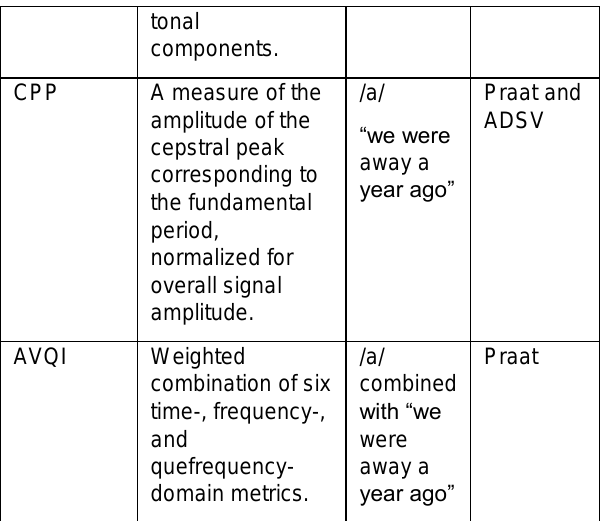
Table 2. Means and Standard Deviations (in